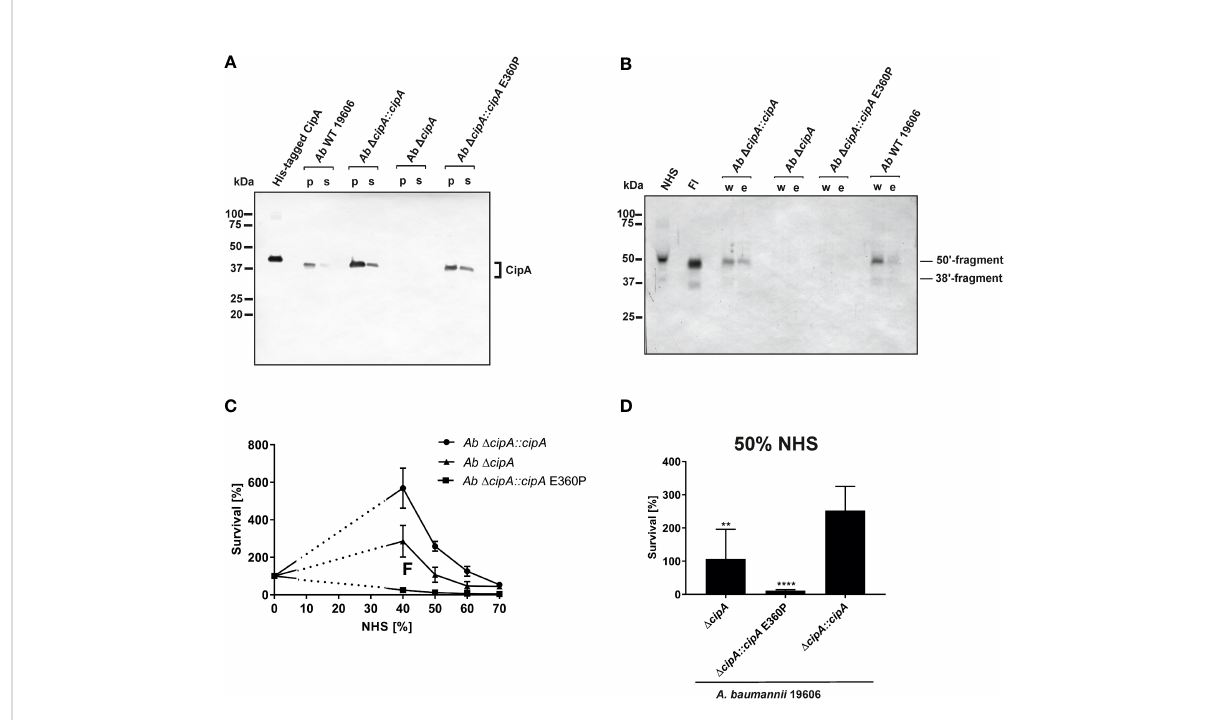
FIGURE 7 Recruitment of serum-derived FI to CipA mediates escape of A. baumannii from complement-mediated killing. CipA production in different A. baumannii strains was veri fi ed by Western blot analysis (A) . CipA was detected in A. baumannii cell lysates (10 µg each) by using an anti-CipA antibody (1:100). Binding of FI to A. baumannii strains upon NHS incubation was assessed by Western blotting using an anti-FI antibody (1:1,000) (B) . Survival of A. baumannii strains in human serum (C , D) . 5 x 10 7 cells of A. baumannii D cipA :: cipA ( ● ), D cipA ( ▲ ), and D cipA :: cipA E360P ( ■ ) were incubated in increasing amounts of human serum for 2 h at 37 °C, serially diluted and cfu counts determined. Cfu counts were related to controls incubated in LB medium instead of serum, for which survival was set at 100%. Shown are results from at least three independent experiments (C) . Survival of A. baumannii strains at 50% NHS (D) . **, p ≤ 0.002, ****, p ≤ 0.0001, n.s., no statistical signi fi cance, one-way ANOVA with post-hoc Bonferroni multiple comparison test (con fi dence interval = 95%). p; pellet; s, supernatant; w, fi nal wash fraction, e; eluate